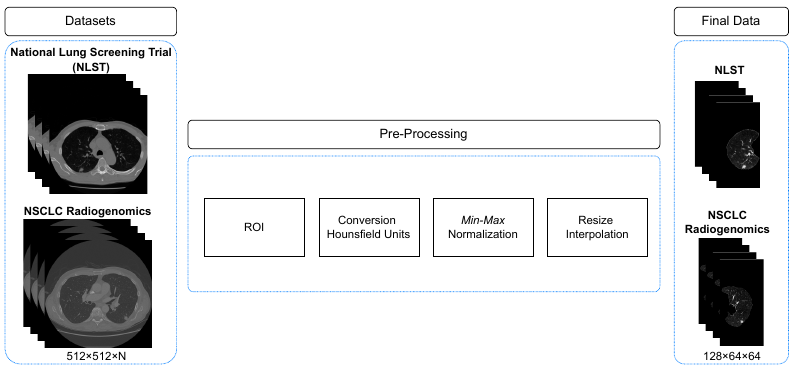
Figure 1. Overview of the pipeline developed for preprocessing the images from the two